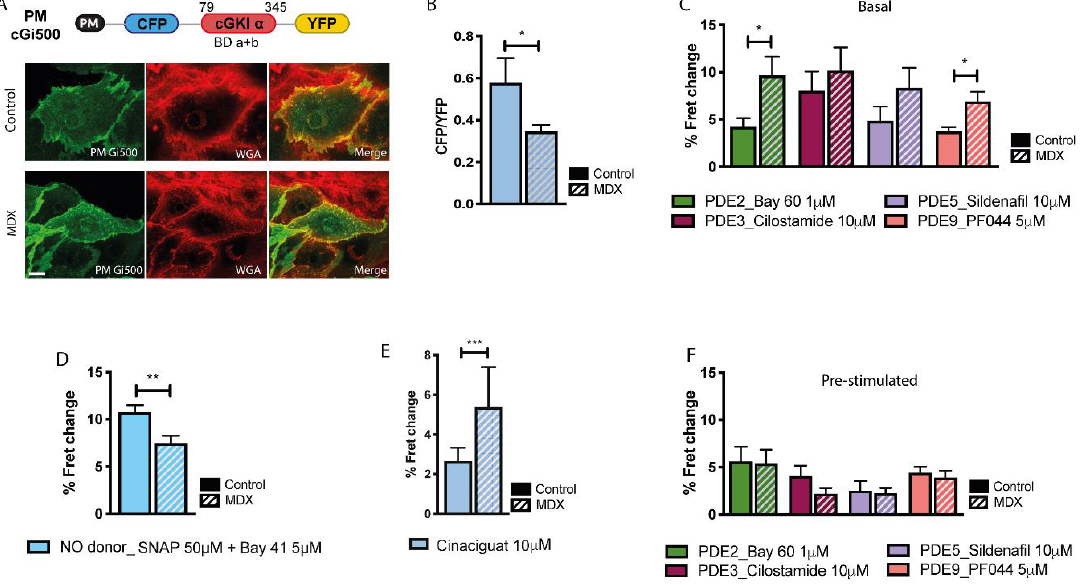
Figure 2. Comparison of cGMP signals at the plasmalemma of NVM from control and mdx mice. ( A ) Top: schematic representation of the plasmalemma-targeted cGMP FRET reporter PM-cGi500. PM,